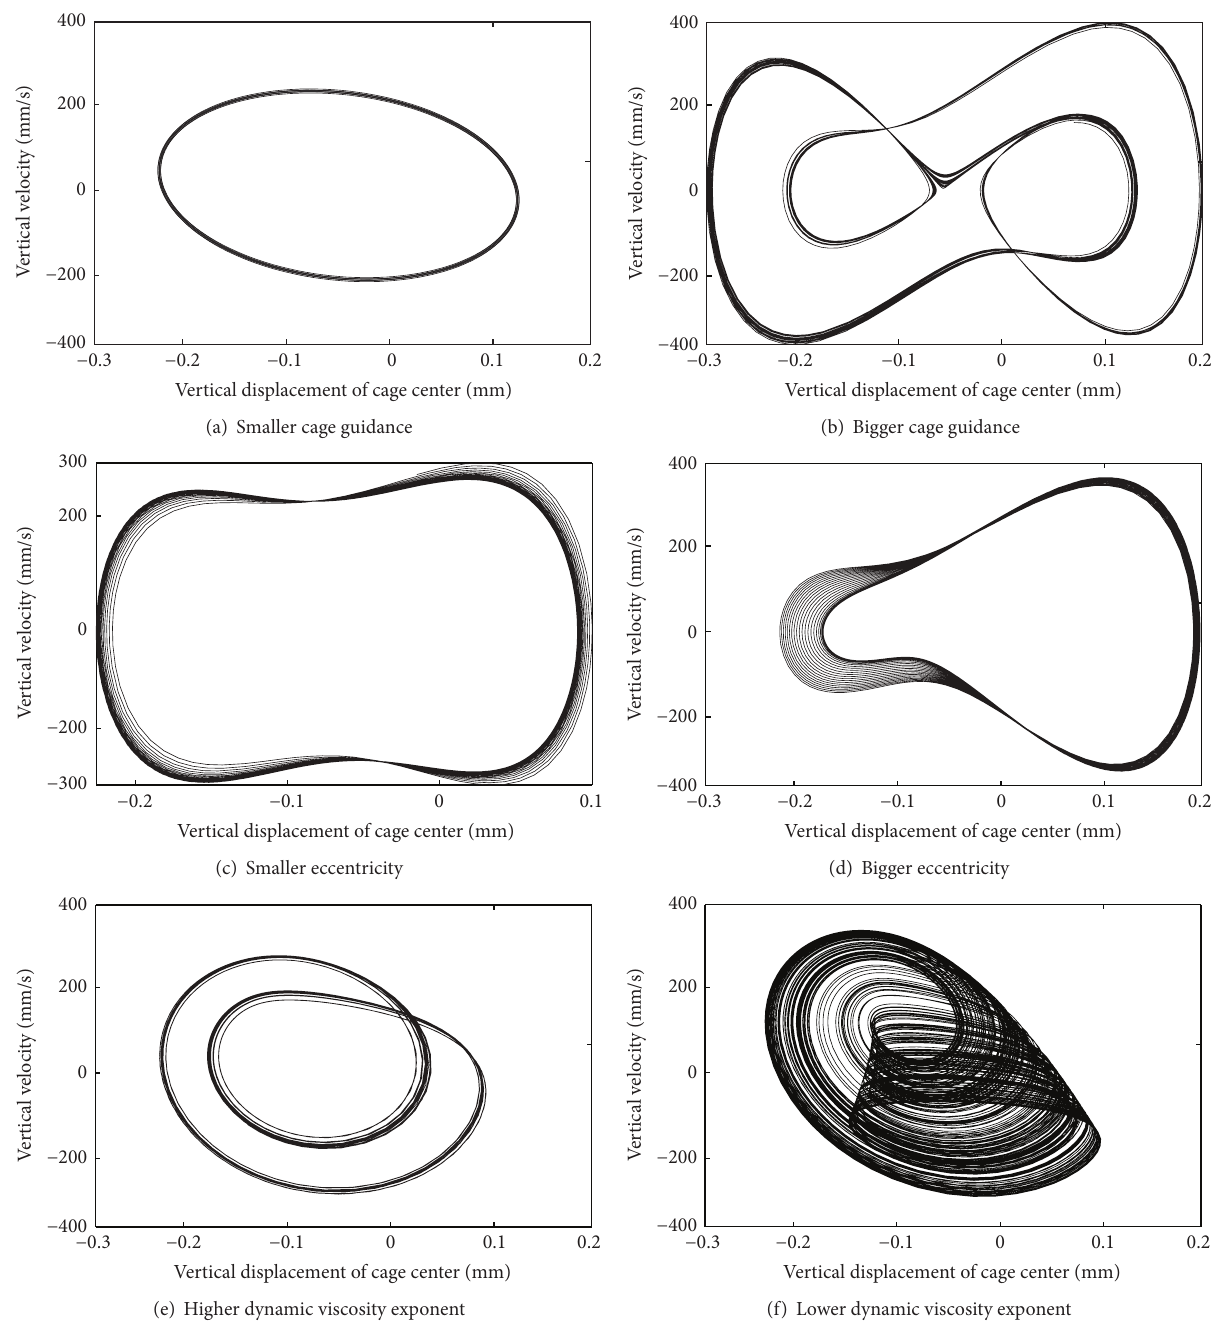
Figure 9: Poincar´e section points of 𝑌 𝐶 displacement in vertical